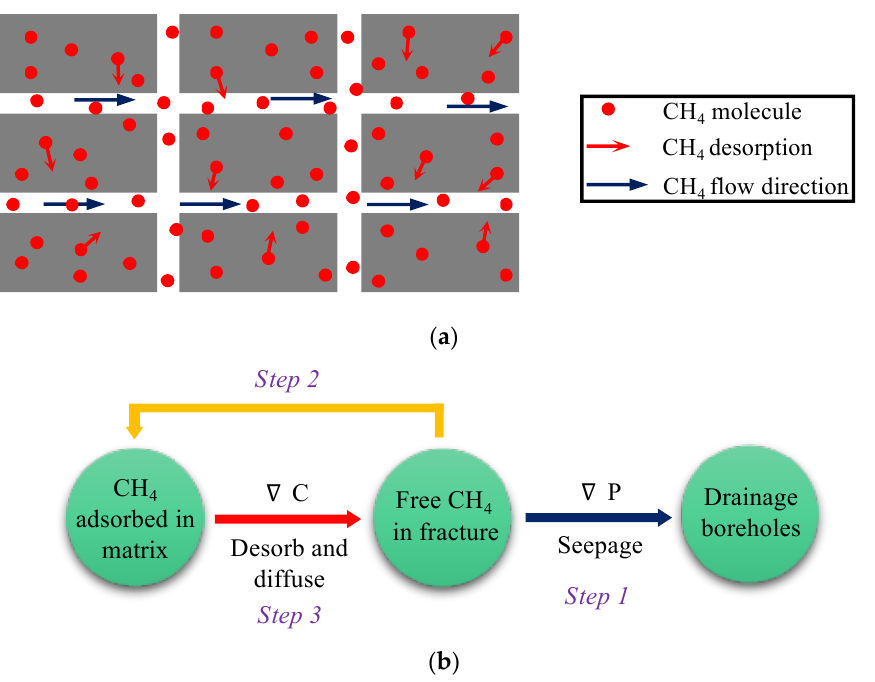
Figure 2. The process of coal seam gas drainage: ( a ) Schematic diagram of the gas migration process; ( b ) Illustration of the conventional drainage mechanism.